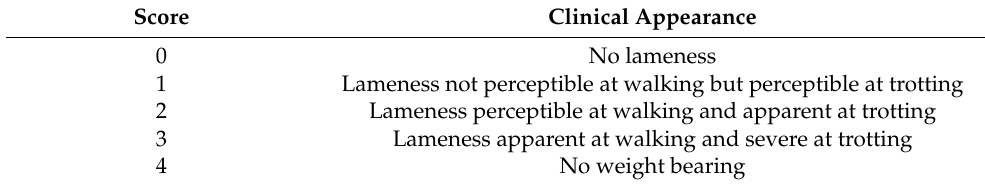
Table 1. Clinical Lameness Score